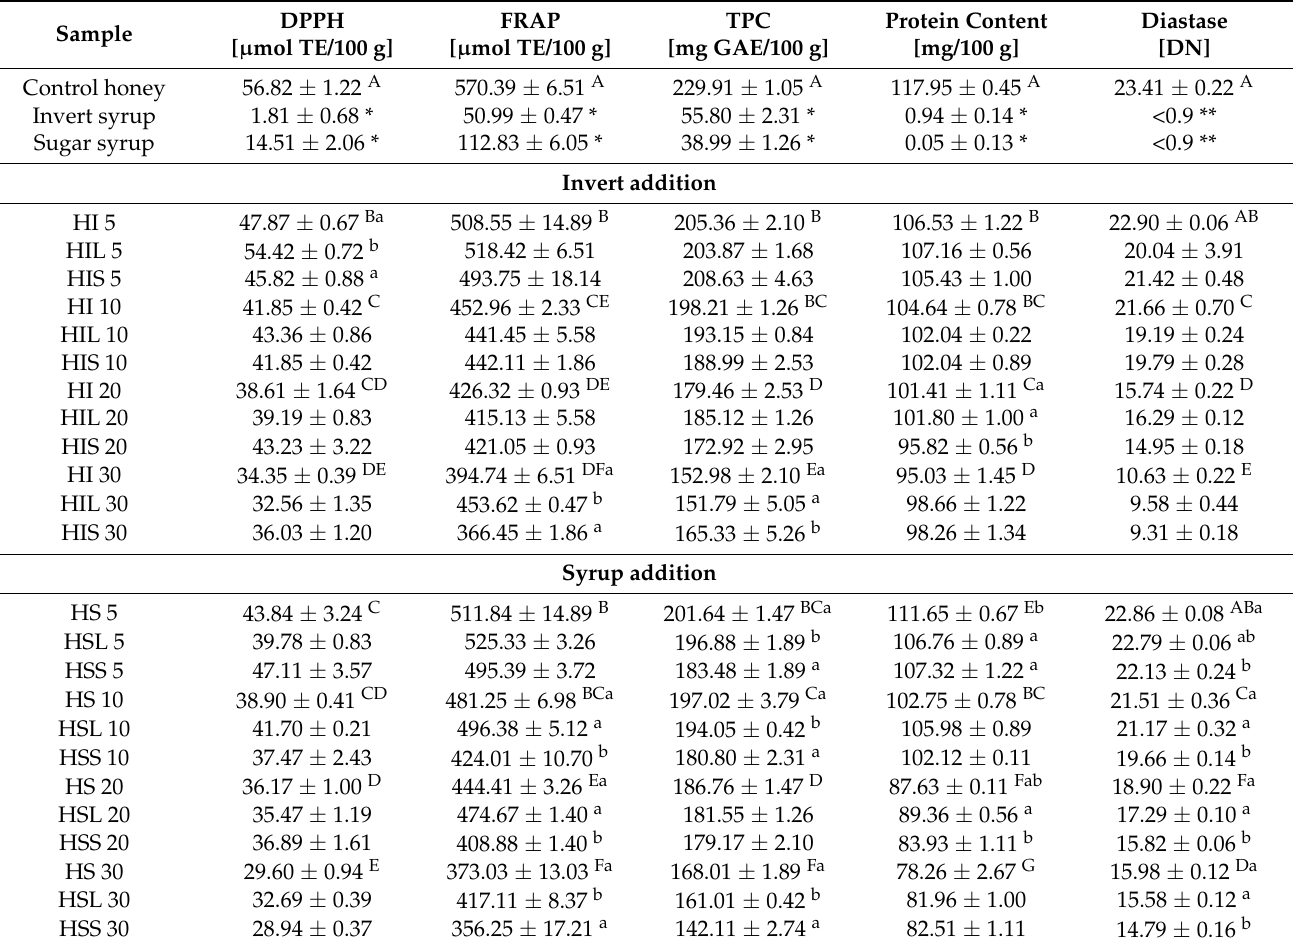
Table 2. Antioxidant activity, protein content and diastase activity of adulterated honey